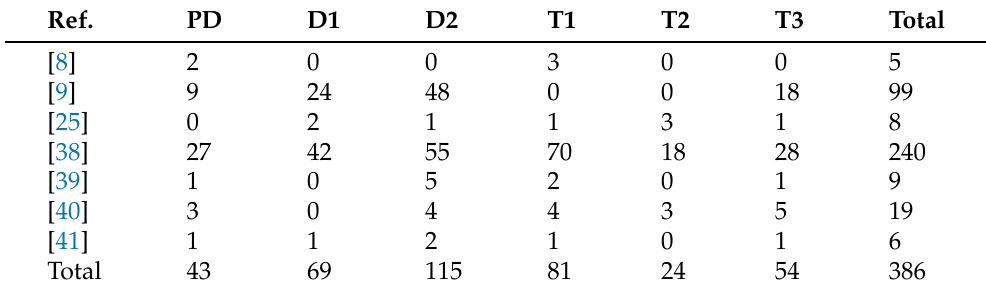
Table 1. Distribution of the 386 training samples according to the fault types and the references. Ref.